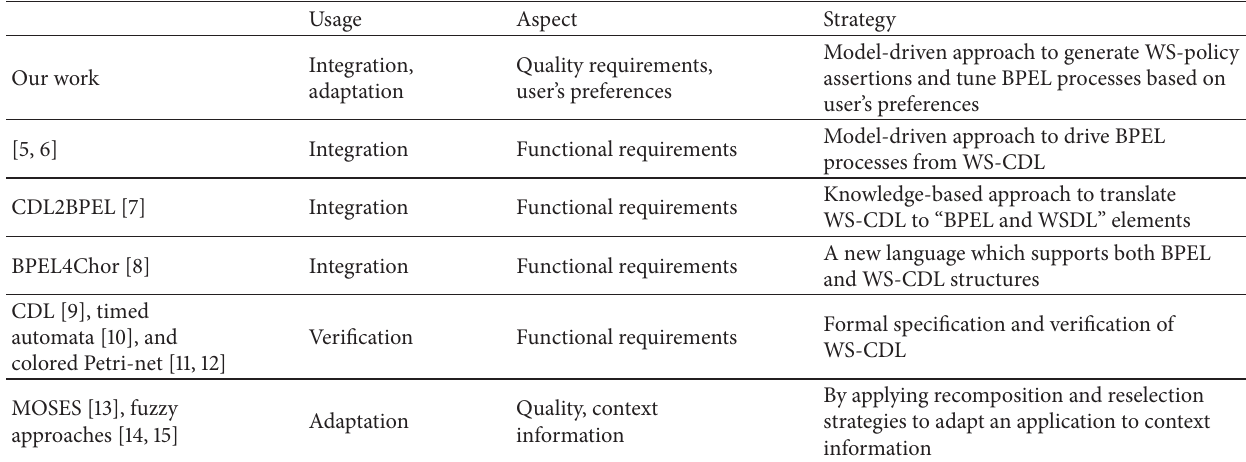
Table 3: Classification